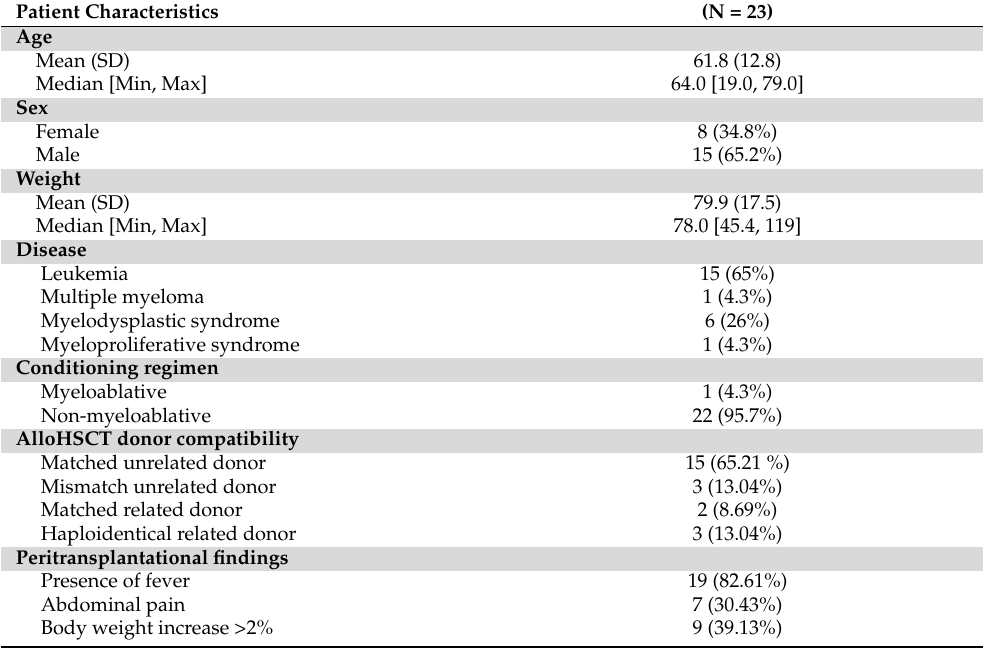
Table 1. Patient